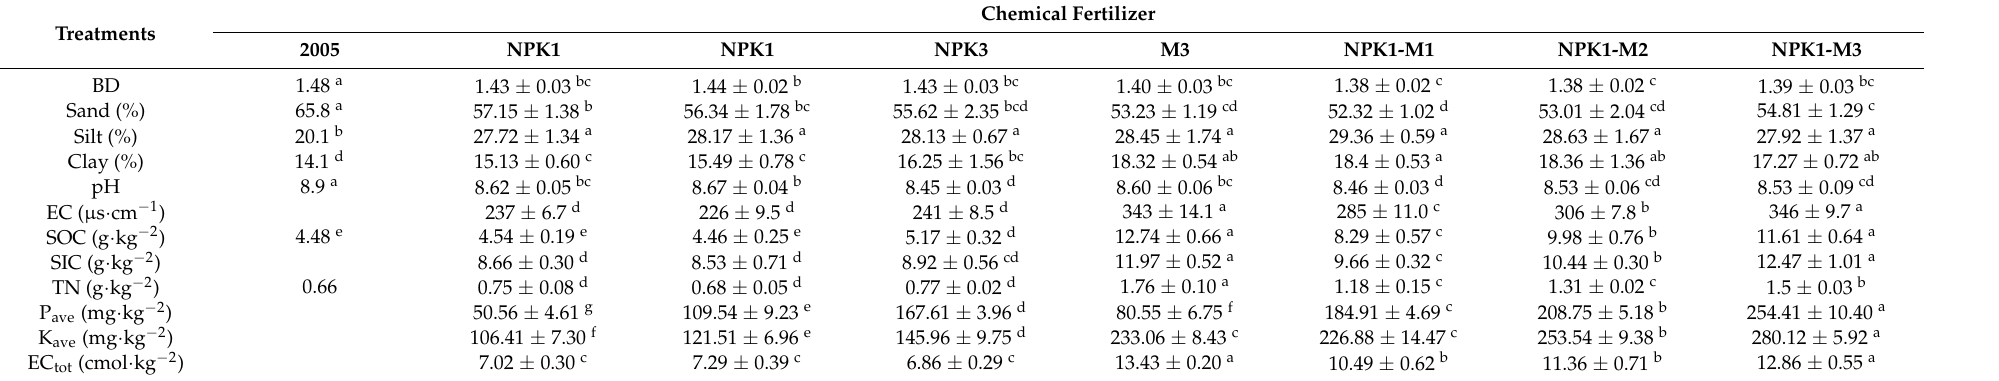
Table 1. Effects of different fertilization types on the physical and chemical properties of